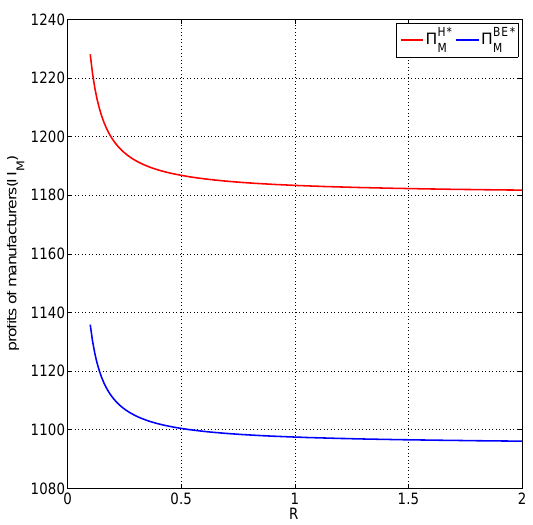
Figure 17. The influences of R on the manufacturer’s profit Π M .